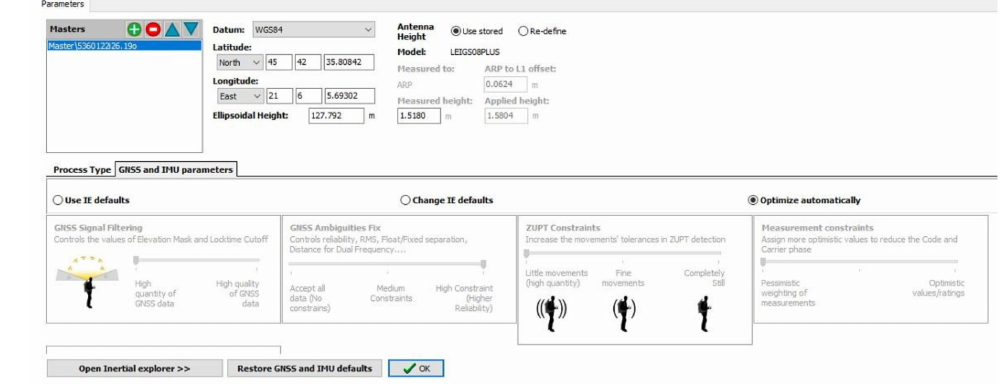
Figure 25. View option in Inertial Explorer (IE).